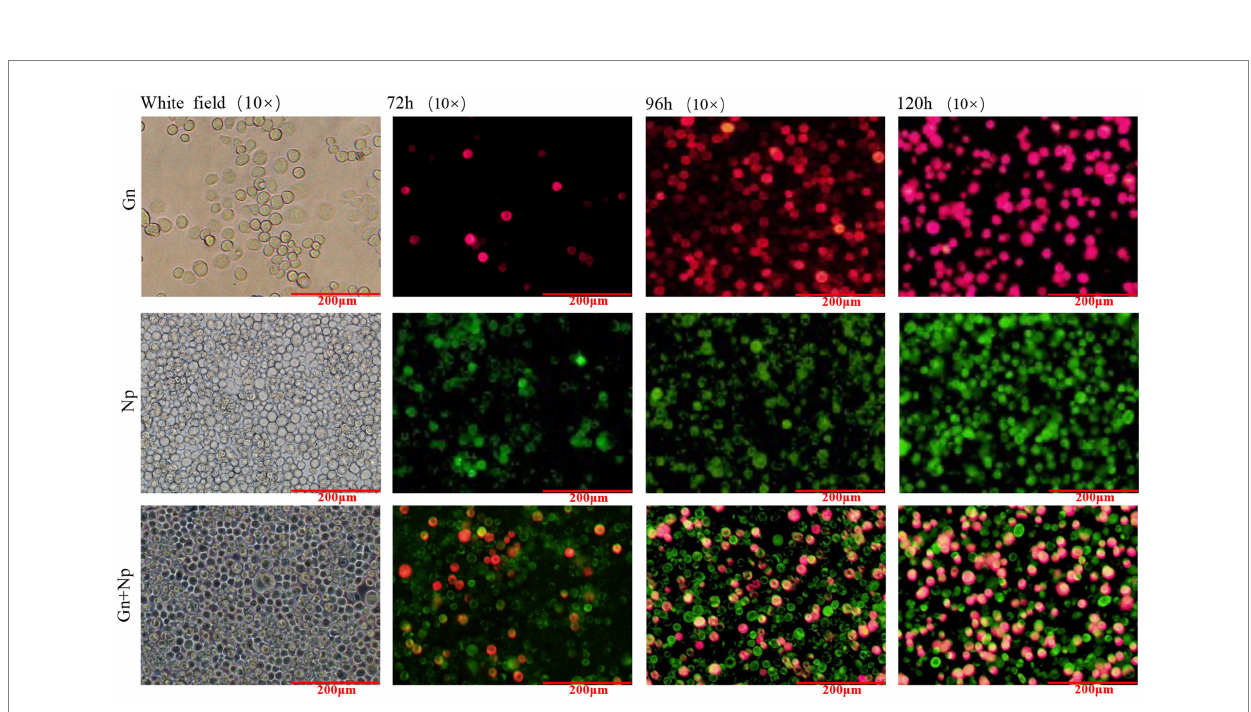
FIGURE 3 Direct fluorescence observation of rvAc-Gn-mCherry, rvAc-Np-eGFP and rvAc-Gn-mCherry-Np-eGFP recombinant bacmids transfected into Sf9 cells (72 h, 96 h, and 120